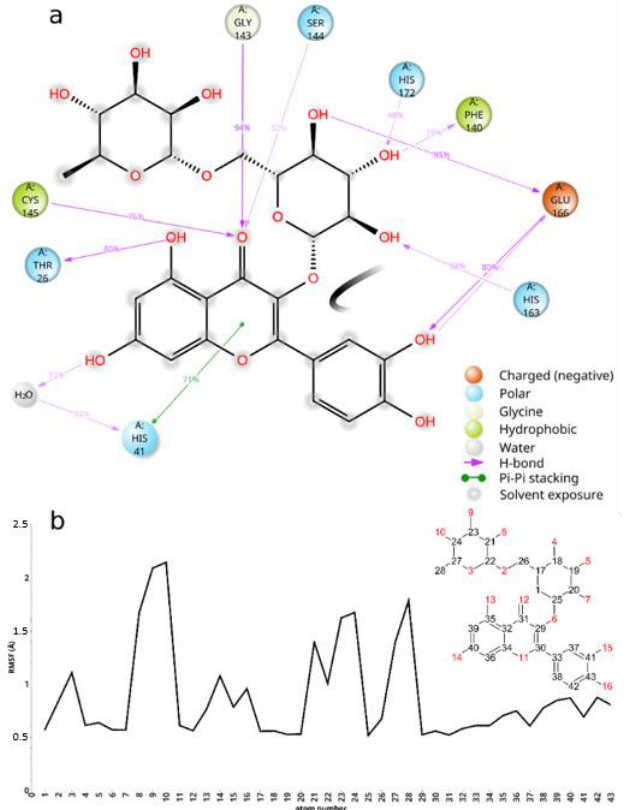
Figure 6. Results summary of rutin/Mpro MD simulations. ( a ) Rutin/Mpro interaction diagram. Only interaction detected for at least 36 ns out of 120 ns of simulation time are shown. ( b ) Root mean square fluctuations of rutin atoms during 120 ns of MD simulation.